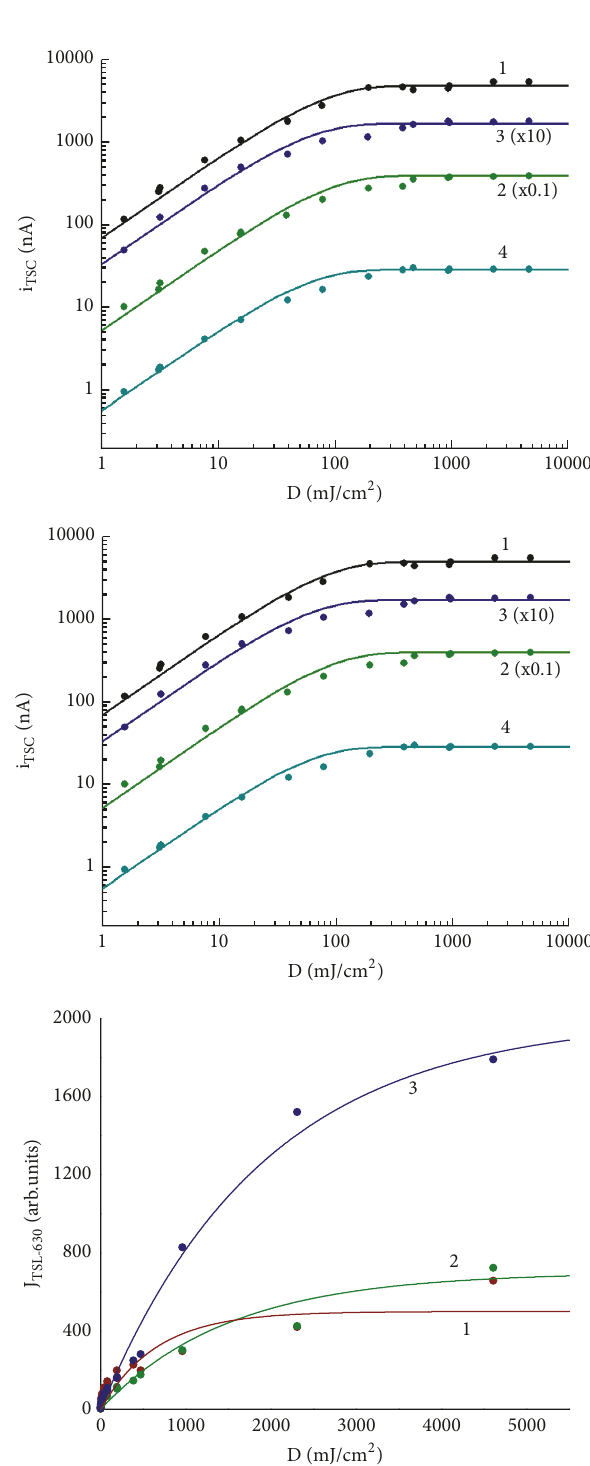
Figure 6: Dose dependencies of the TSL-630 peaks at 𝑇 m = 129 K (1) , 184 K (2) , and 211 K (3) of the sample #1 under two intensities of X-ray excitation and the theoretical curves of the light sum accumulation (solid